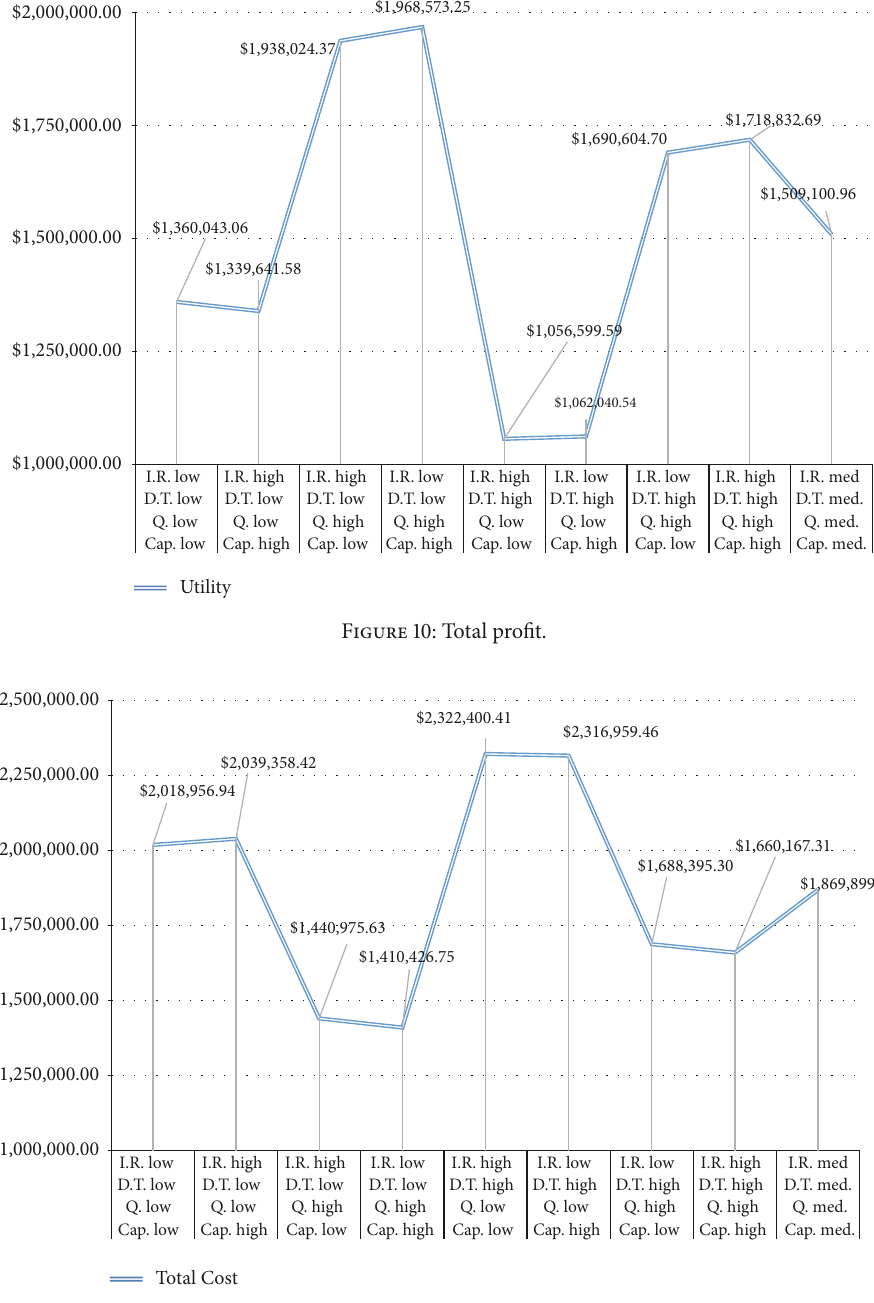
Figure 11: Total